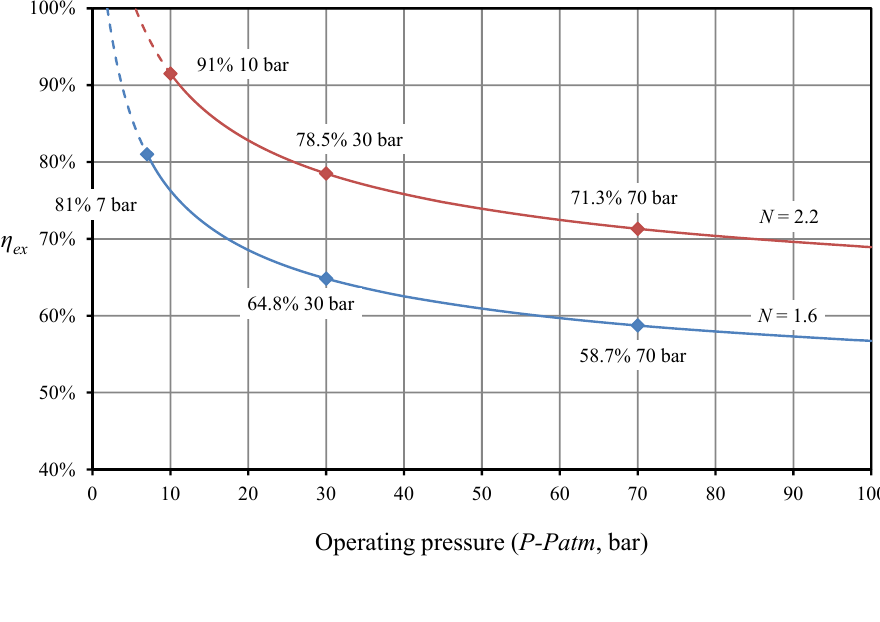
Figure 9. The converting efficiency under the expansion